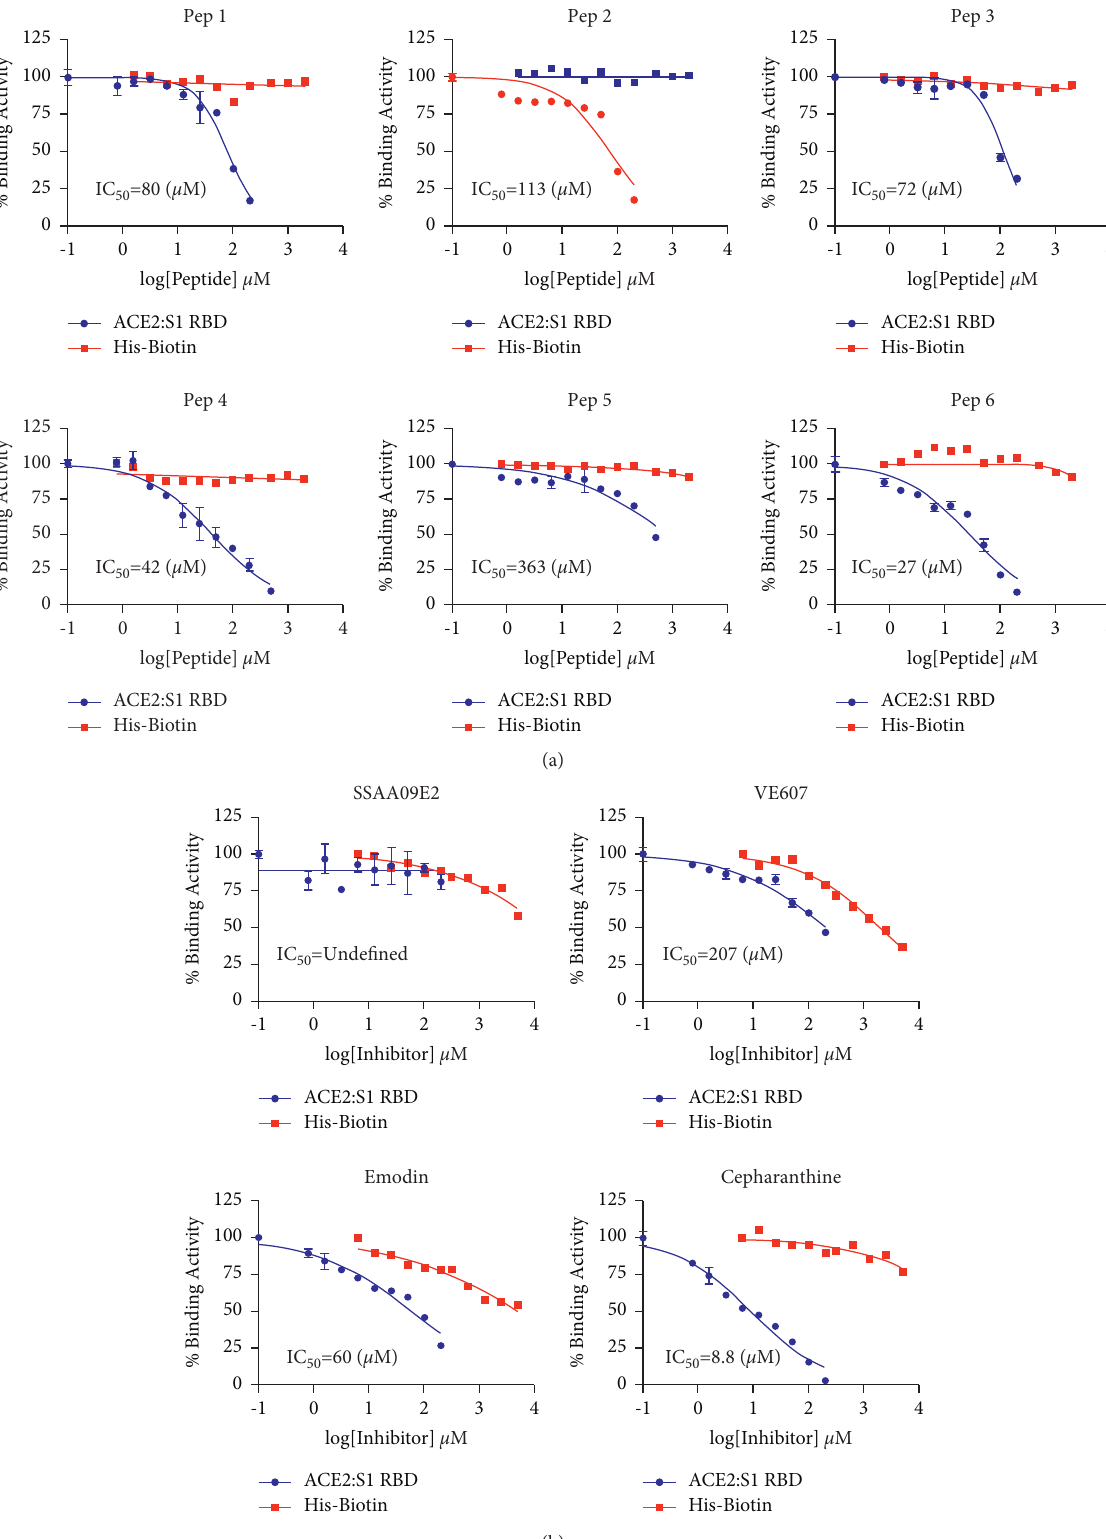
Figure 4: Activity of peptides and small molecules against ACE2 :S1 RBD binding. (a) Dose-response of the peptide candidates (Pep 1–6) against the binding of ACE2 and S1 RBD shown in blue and the respective half-maximal inhibitory concentrations. (b) Dose-response relationships of the 4 small molecules we tested for competitive inhibition of ACE2 :S1 RBD